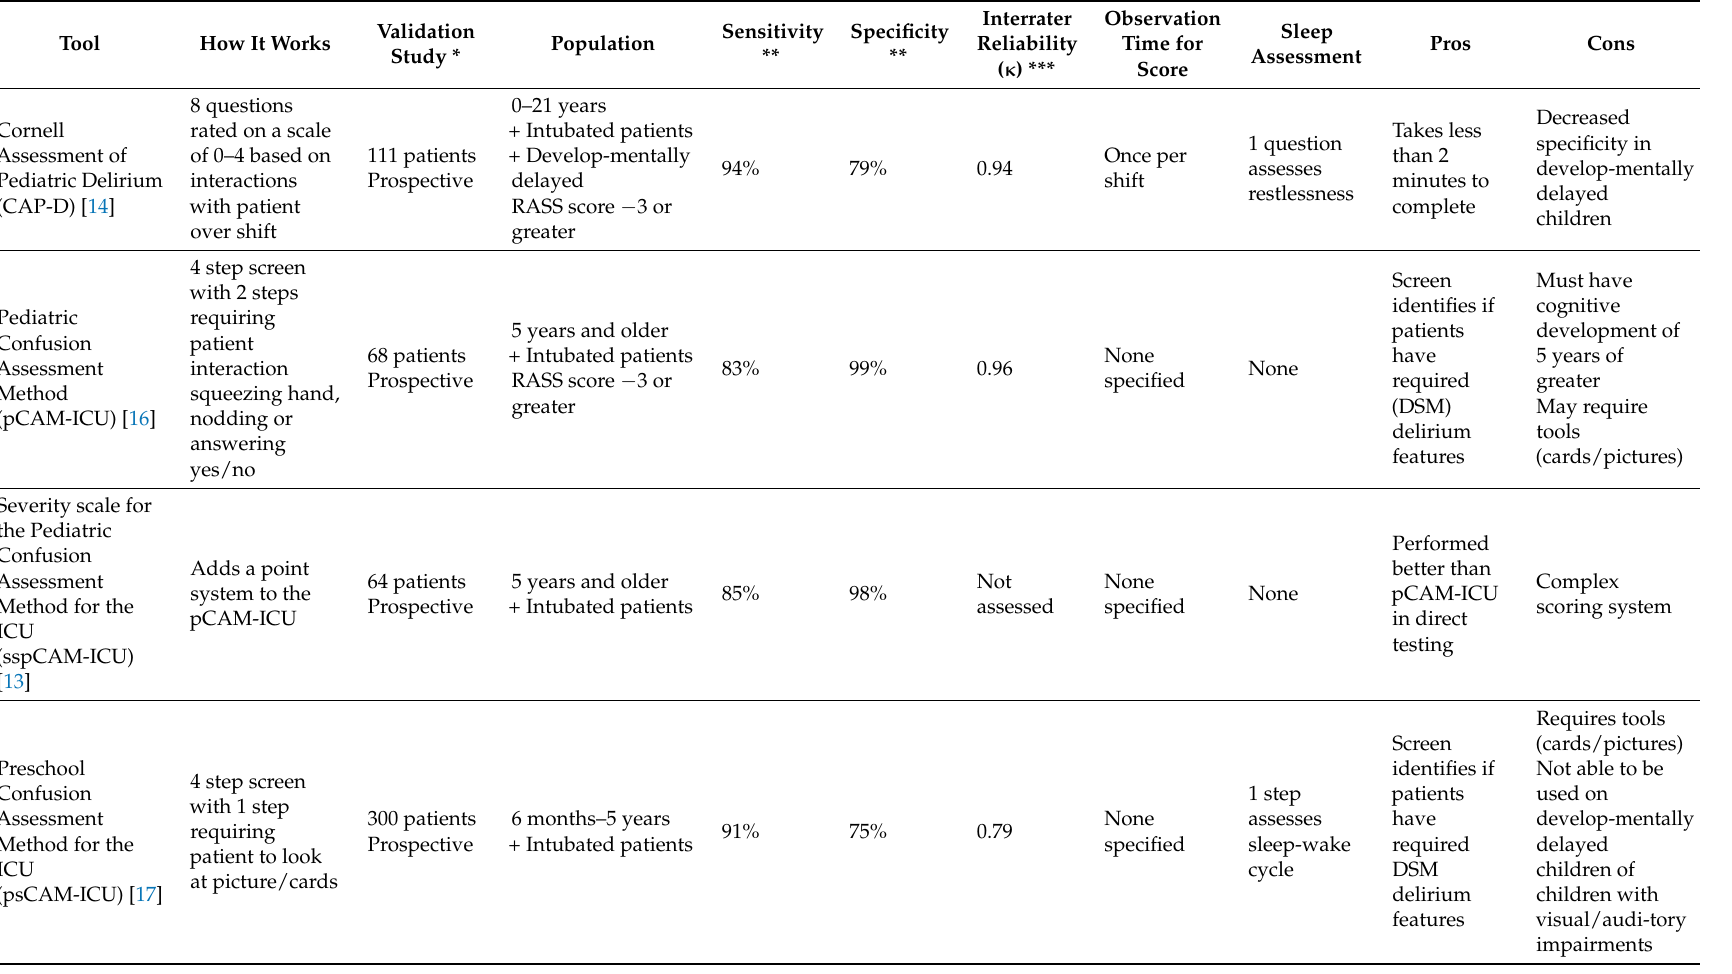
Table 1. Advantages and Limitations of Pediatric Delirium Screening